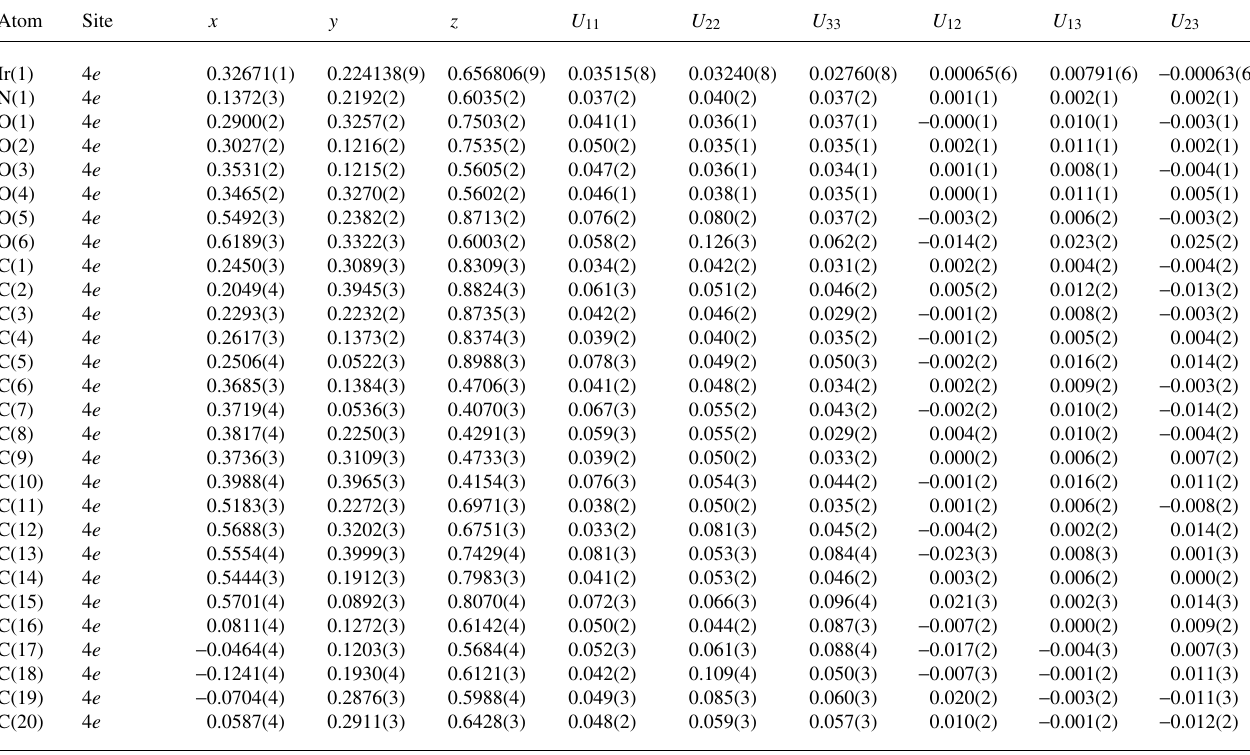
Table 3. Atomic coordinates and displacement parameters (in Å 2 )